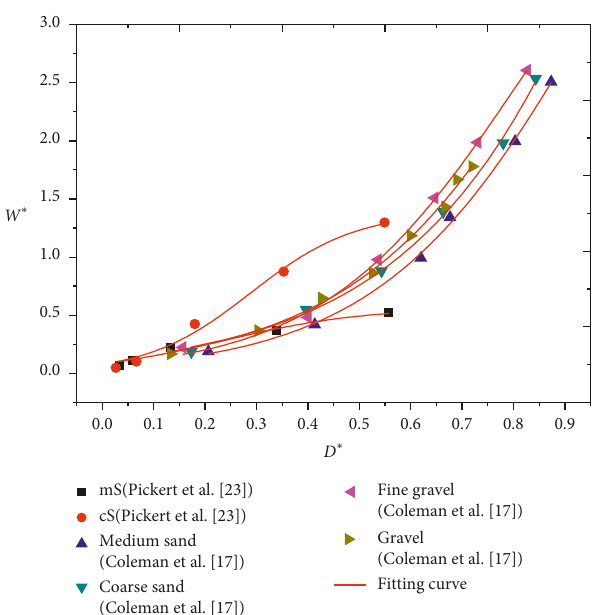
Figure 14: The relationships between breach width and depth in dimensionless formation. The scatter points were measured data by Coleman et al. [17] and Pickert et al. [23]. The fitting curve in the figure is analyzed based on equation